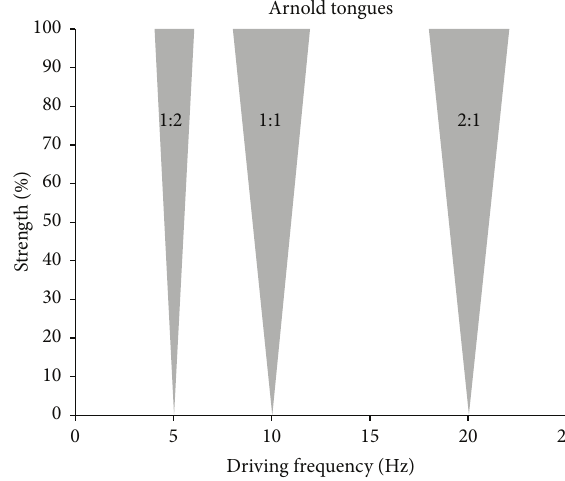
Figure 5: Theory of entrainment. If the brain is stimulated near its “Eigenfrequency,” that is, the individual alpha activity around 10 Hz, the EEG will synchronize to the frequency of the driving force (e.g., tACS). This is considered synchronization or entrainment of an oscillator by an external driving force and depicted in gray (1: 1 region). If, however, the stimulation frequency is far from the “Eigenfrequency,” the EEG will be dominated by its “Eigenfrequency” (white regions of diagram). If the strength of the external driving force (tACS) increases, the synchronization regions will become wider in frequency. Due to this triangular shape the synchronization region is referred to as an Arnold tongue [51]. Synchronization can also happen at harmonics ( 𝑁 ∗ Eigenfrequency) and subharmonics (Eigenfrequency /𝑁 ) where 𝑁 is an integer (1:2 and 2 :1 show here). They do not need to have the same shape and